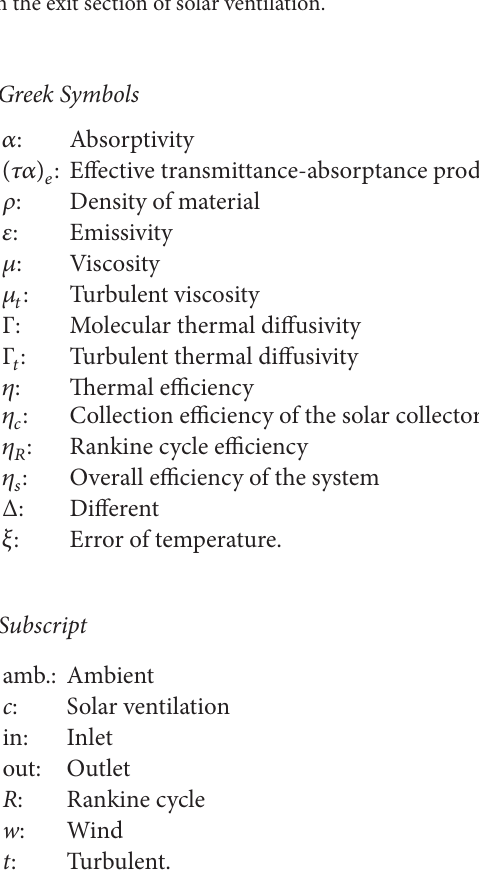
Figure 10: The temperature distribution in the exit section of solar ventilation.